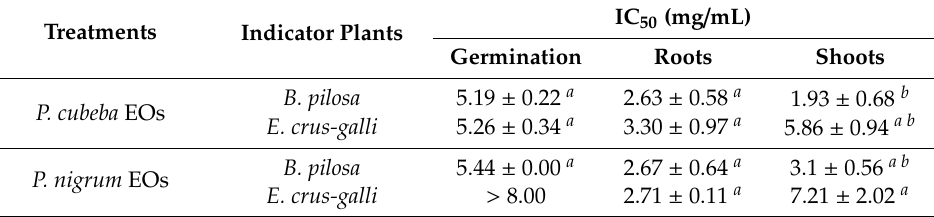
Table 2. Inhibition (IC 50 ) values of P. cubeba and P. nigrum EOs on some indicator plants.